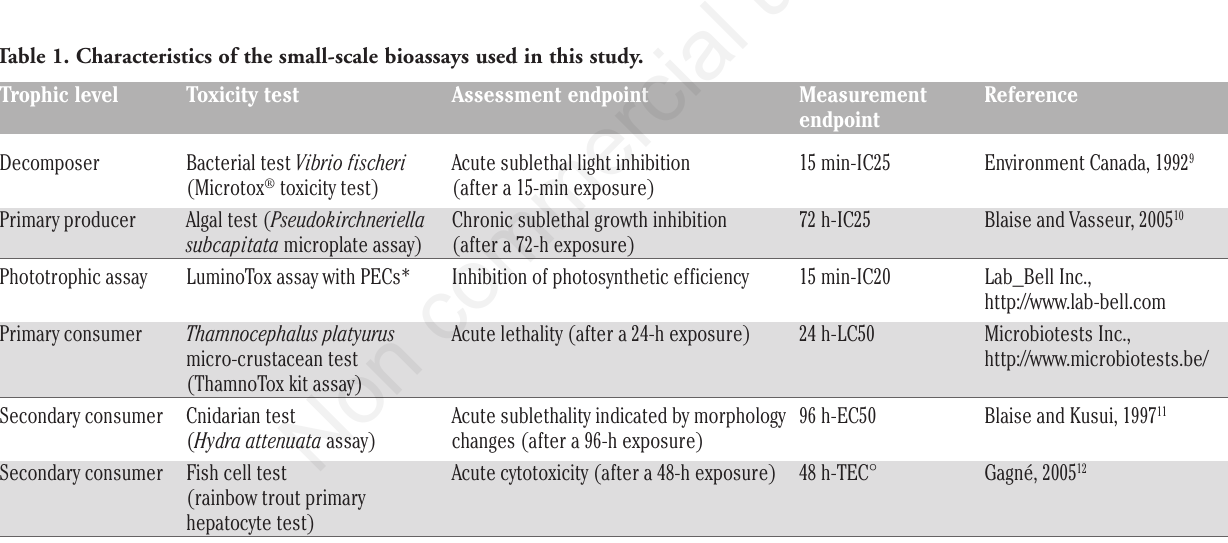
Table 1. Characteristics of the small-scale bioassays used in this study.